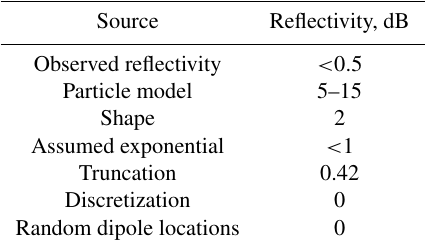
Table 2. Contributions to uncertainties in forward-modeled and ob- served